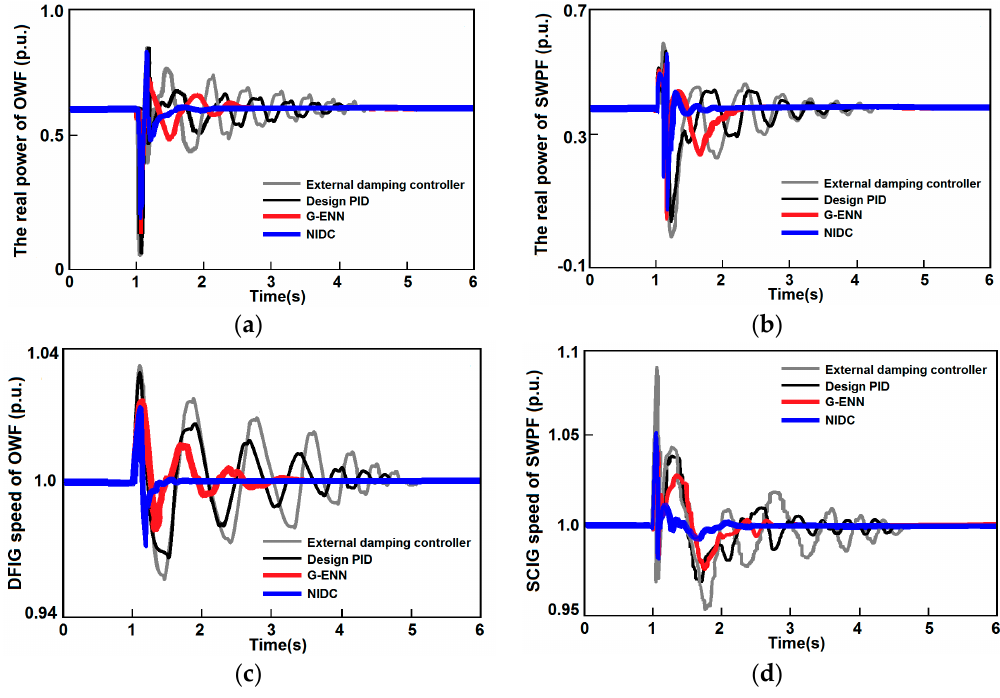
Figure 7. The responses of transient stability for OWF and SWPF in Case 1 ( a ) The real power of OWF; ( b ) The real power of SWPF; ( c ) The DFIG speed of OWF; ( d ) The SCIG speed of SWPF.